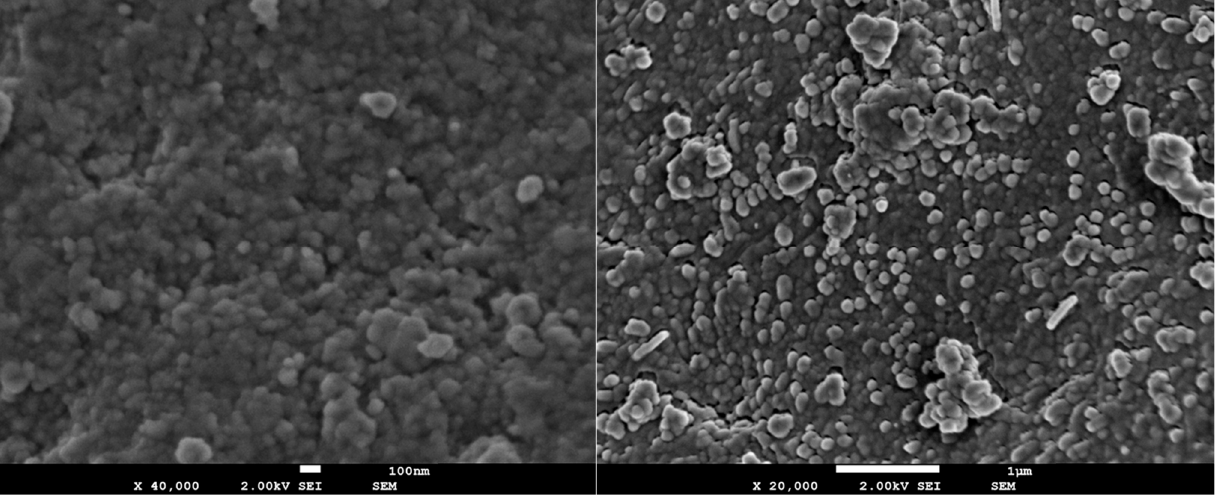
Figure 3 . Representative SEM micrographs at ×40,000 ( left ) and ×20,000 ( right ) magnification of NPs in the composition of akermanite enriched with Cu and Sr ions (nAkCuSr).